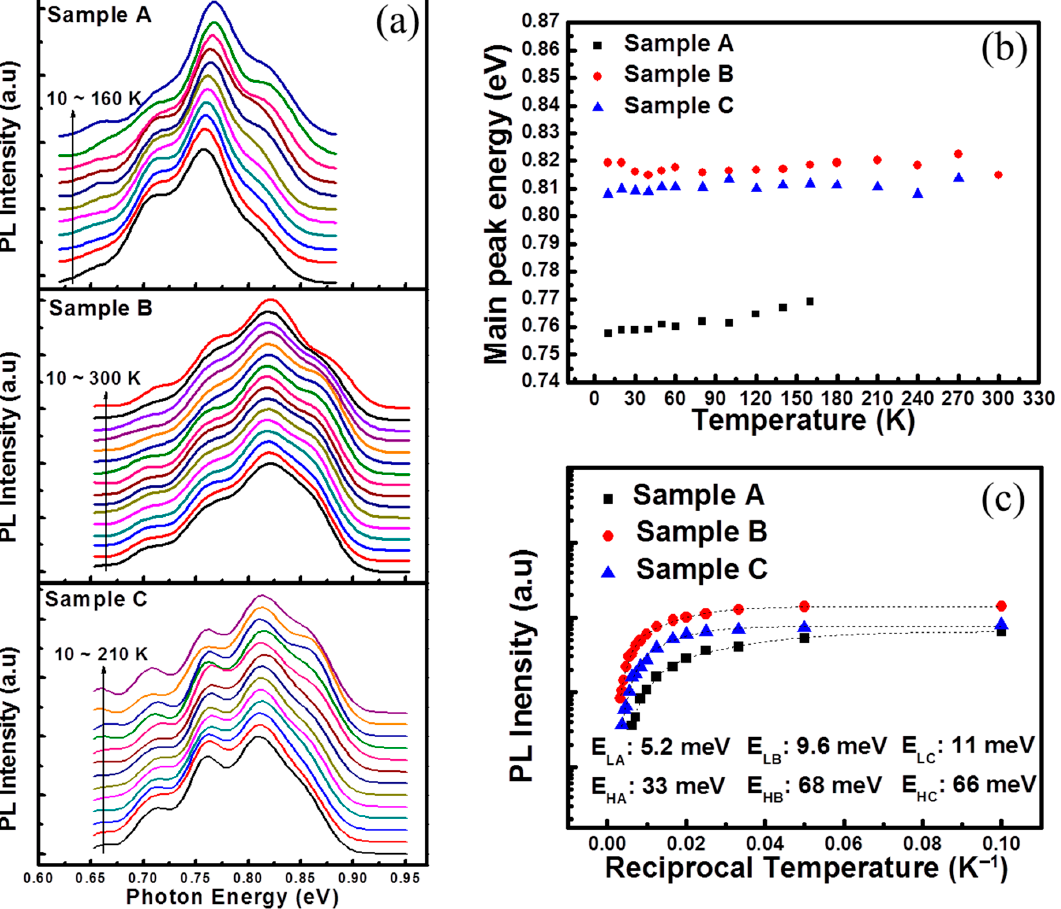
Figure 4. ( a ) Temperature-dependent PL spectra of three InN samples, the temperature range varied from 10 K to 300 K. ( b ) The main peak energy of sample A, B and C. Only sample A shows significant blue shift, and the other had nearly no shift. ( c ) Arrhenius plot of integrated PL intensity of samples with different growth temperatures. Dash line was the fitted curve by Equation